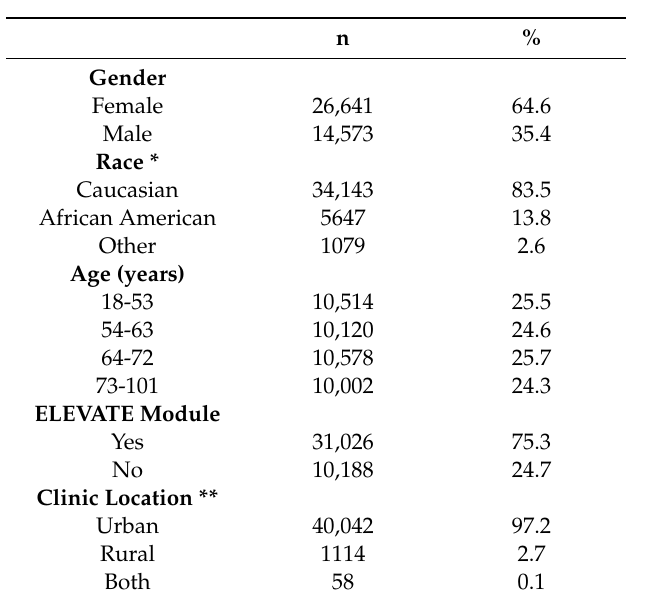
Table 4. Sample demographics among patients in cancer clinics (n =